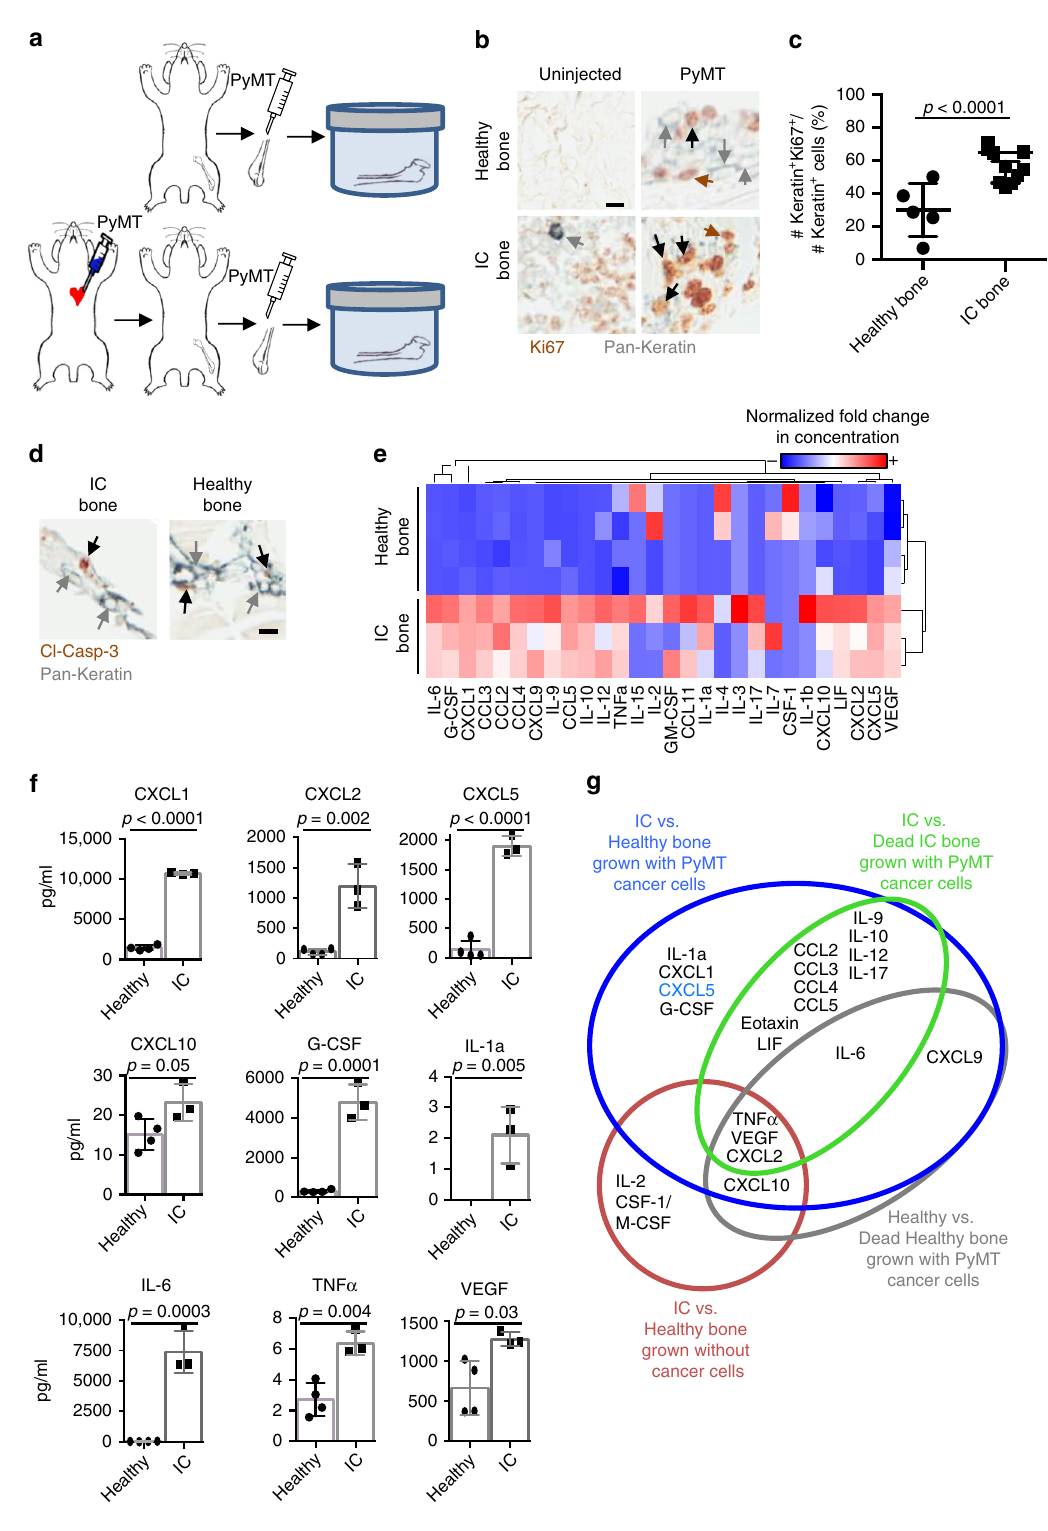
differentially expressed factors produced exclusively in cultures with cancer cells included interleukin (IL)-1a, CXCL1, CXCL5/ LIX, granulocyte colony-stimulating factor (G-CSF),